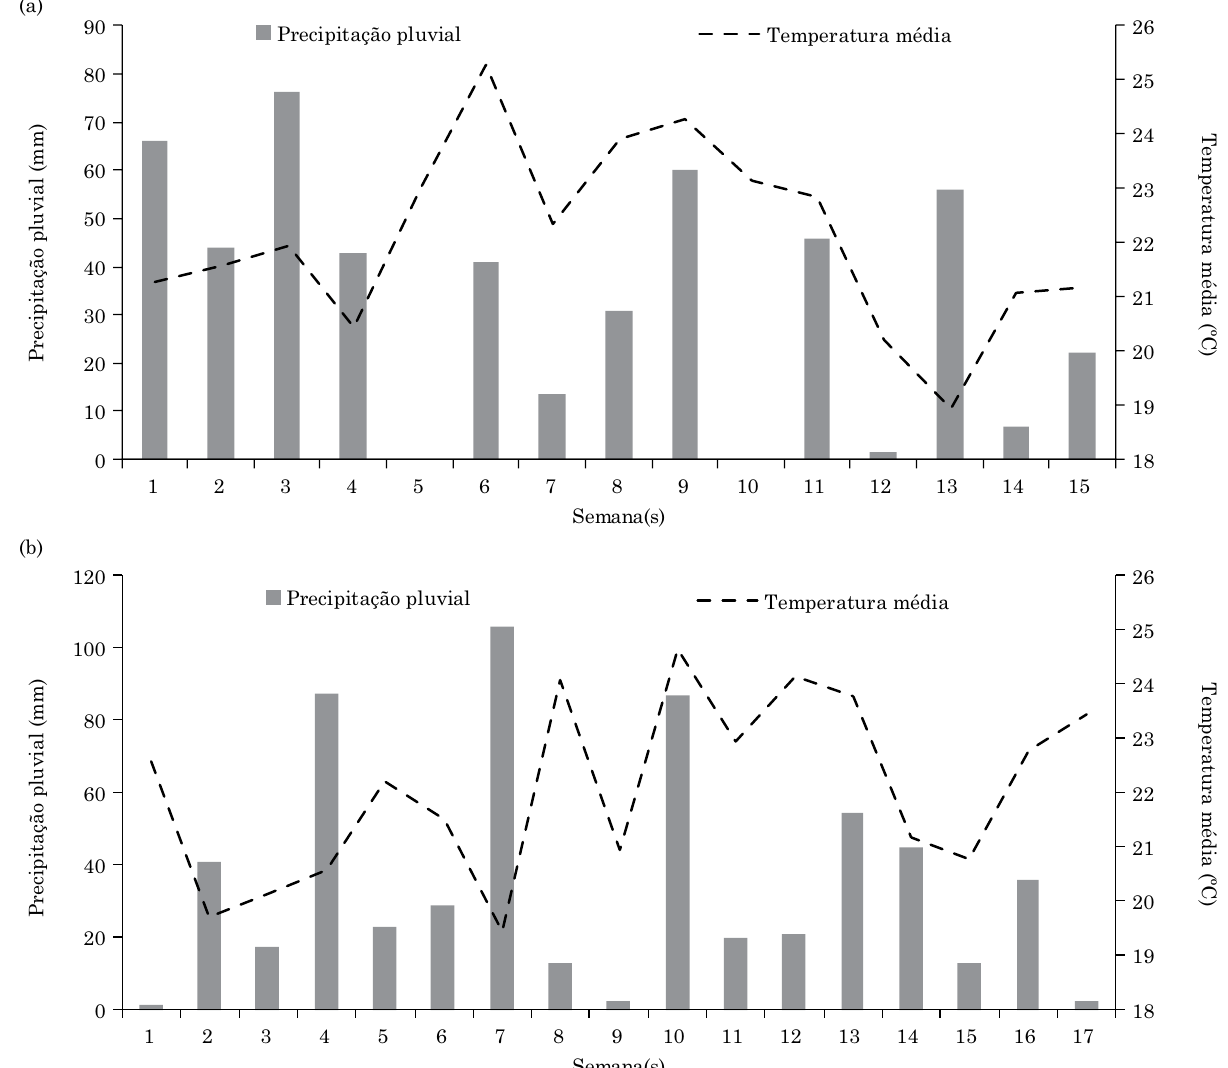
Figura 1. Precipitações pluviais e temperaturas médias referentes aos períodos experimentais das safras da seca - 2012 (a) e das águas - 2012/2013 (b). estação experimental do Iapar, Ponta Grossa,